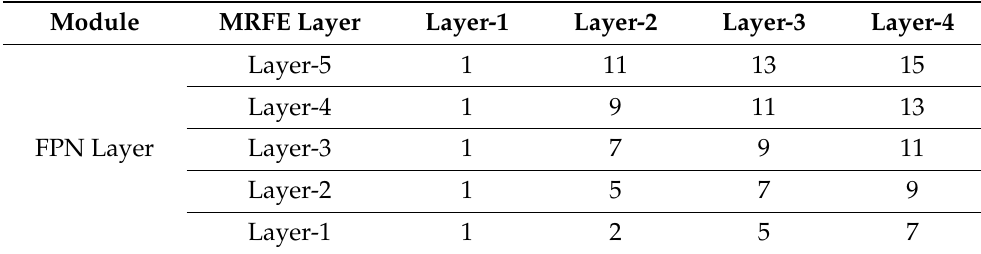
Table 1. Table of dilated coefficient in ASPP